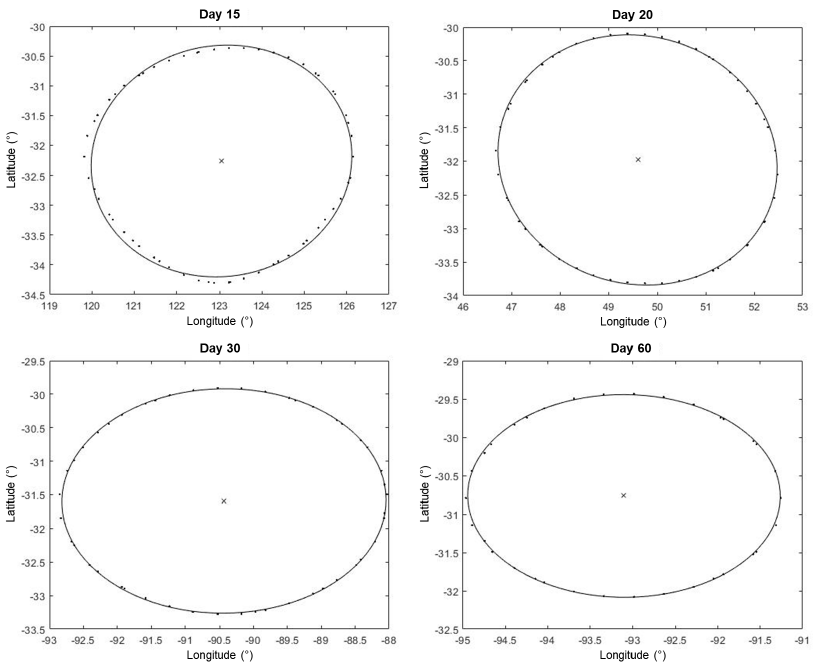
Figure 4. Elliptical vortex fits of closed potential vorticity contours at 700 hPa for Simulation 3. Points are the data from the potential vorticity contour, the line is the elliptical fit.